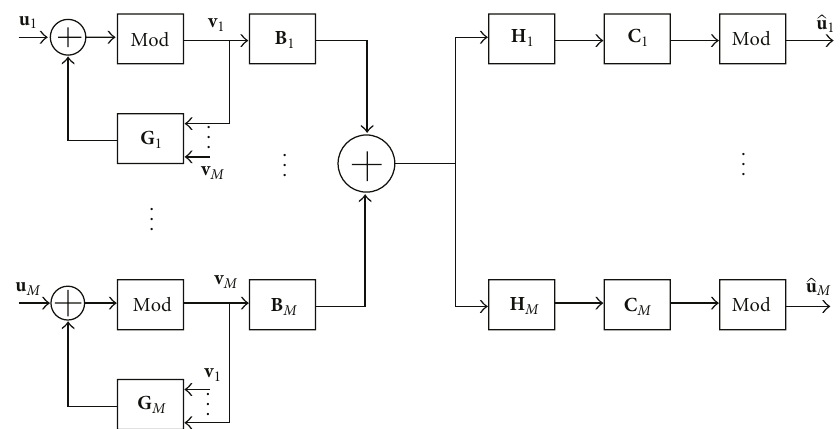
Figure 1: Multiuser MIMO downlink system model with Tomlinson-Harashima